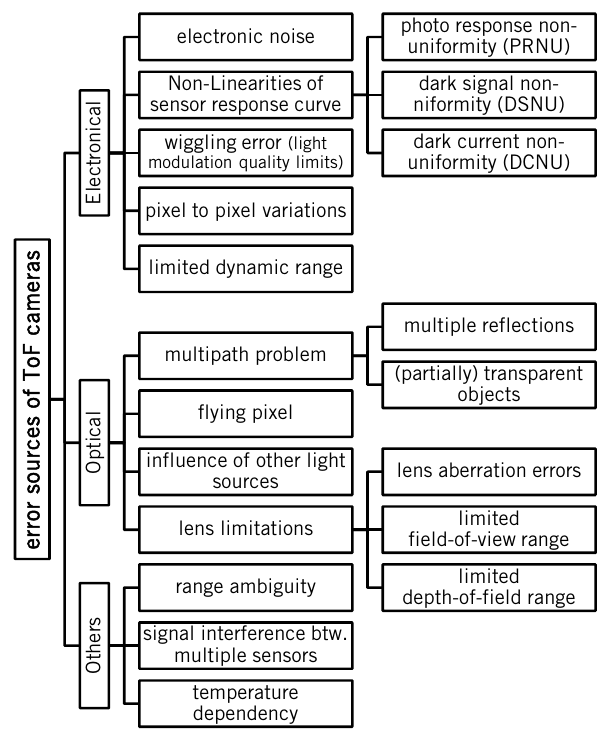
Figure 2. Important error sources in Camera-based Time-of- Flight Sensors (based on error investigations given by (Herbert and Krotkov, 1992), (Adams and Probert, 1996), (Schmidt, 2011), (Grzegorzek et al., 2013), (Meister,